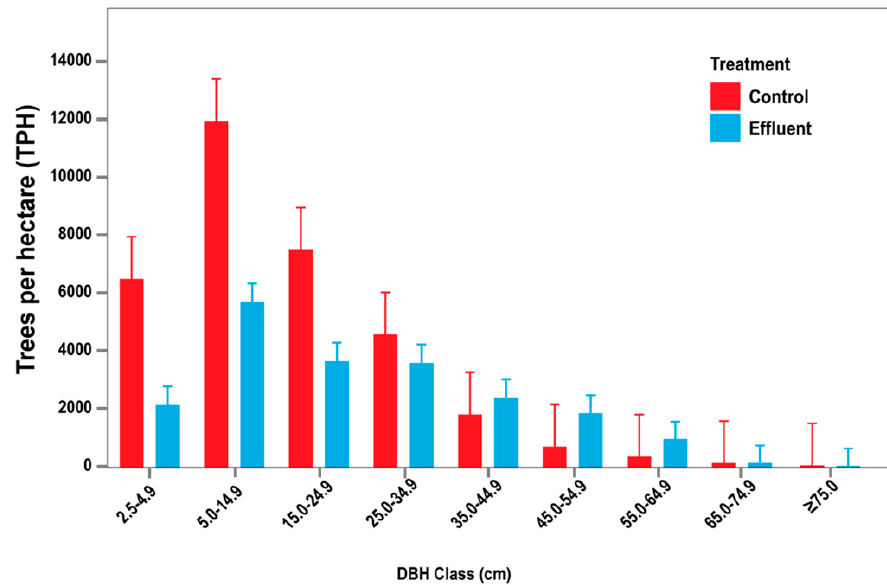
Figure 3. Size class distribution of control and effluent treatment plots at the five reuse facilities.